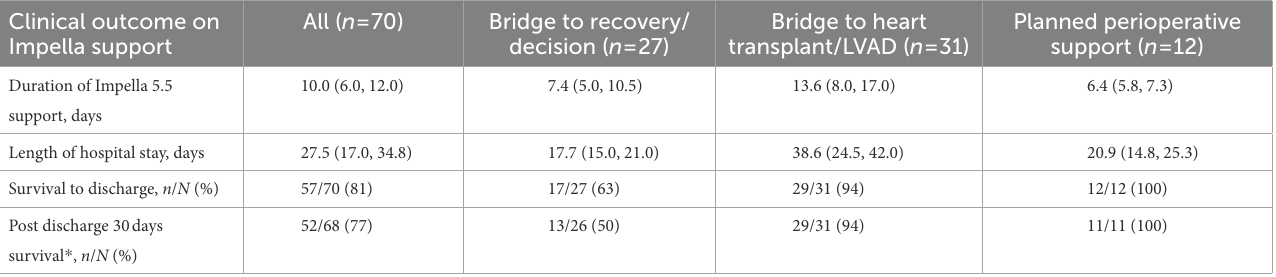
TABLE 2 Clinical outcomes on Impella